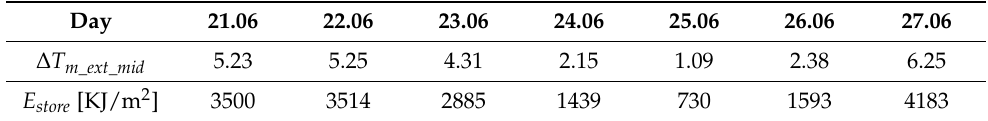
Table 4. Energy stored in the wall for the following days of the summer week.